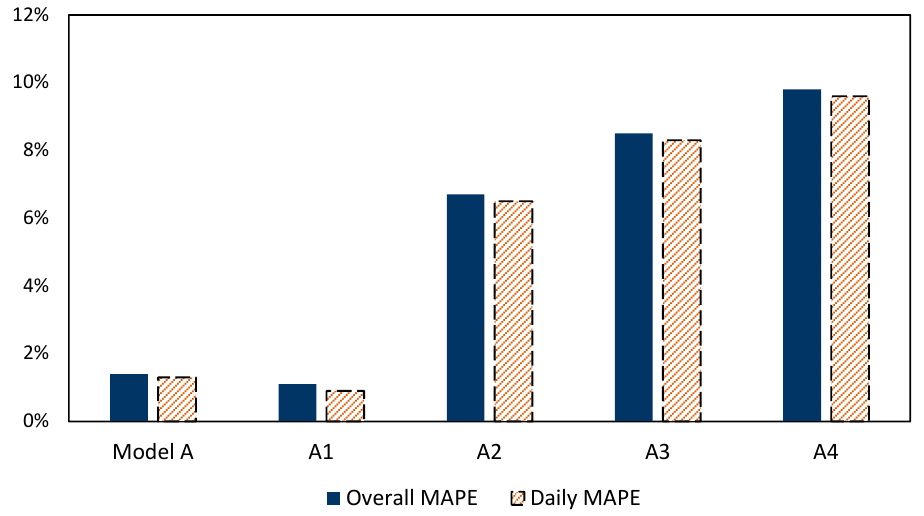
Figure 14. The overall and daily MAPE for ANN forecast model with input exogenous variables. In order to investigate the correlation between the exogenous variables ( A (cid:2869) , A (cid:2870) , A (cid:2871) , A (cid:2872) ) and the the water level H(t) , Table 7 presents the R-squared values for the linear relation- ship between them. The R-squared is a statistical analysis tool that aims to show the cor- relation between variables. The water level of previous time steps from 20 min until one hour ( A (cid:2869) ) showed a direct and high correlation with R-squared equal to 93.7%. The exog- enous variables ( A (cid:2870) , A (cid:2871) , A (cid:2872) ) showed a limited correlation compared to A (cid:2869) with R-squared below 52 %. Therefore, using of A (cid:2869) with Model A showed most accurate results com- pared to other exogenous variables as shown in Figure 14. Table 7. The R-squared values for the relationship between H ( t ) and (A 1 , A 2 , A 3 , A 4 ) . Correlated Variables